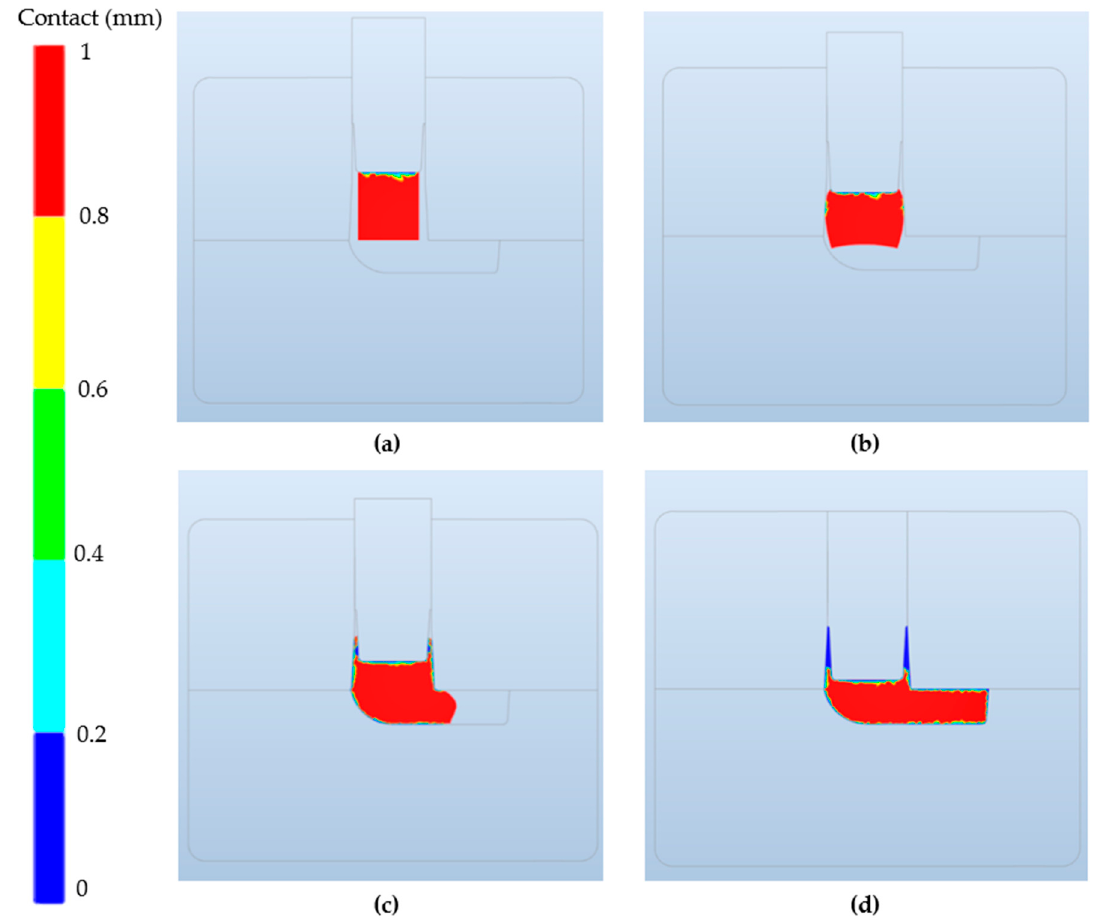
Figure 5. Component filling illustration at different punch positions during the NSF process (Stage III in Figure 4) using FORGE ® simulation software. ( a ) Initial position, ( b ) 46 mm punch displacement, ( c ) 62 mm punch displacement and ( d ) complete filling. The blue color means contact with the dies/punch. The red color shows those areas that are more than 0.8 mm distance from dies and punch.